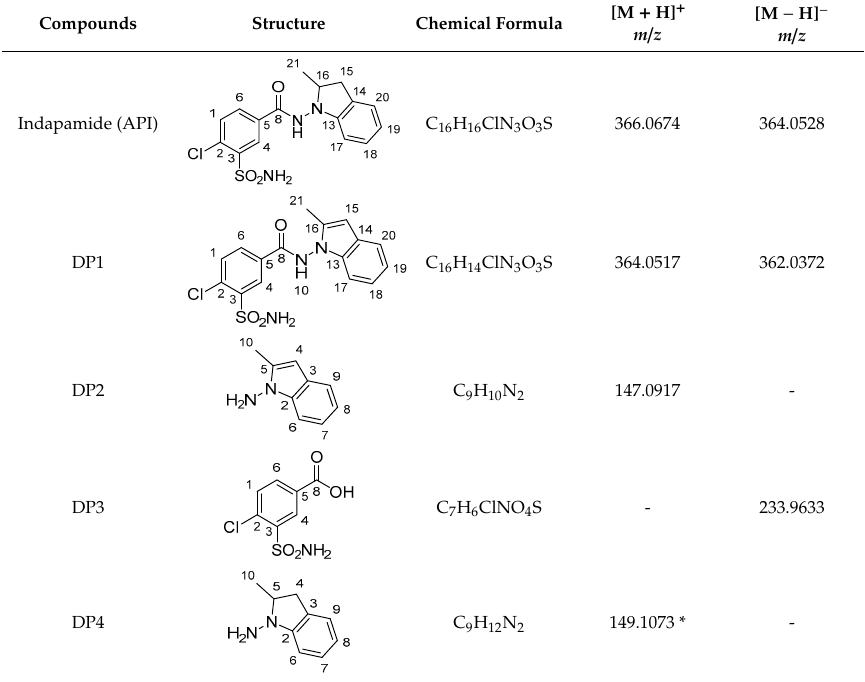
* weak (this compound mainly generates a [M − 2H + H] + at m / z 147.0917).